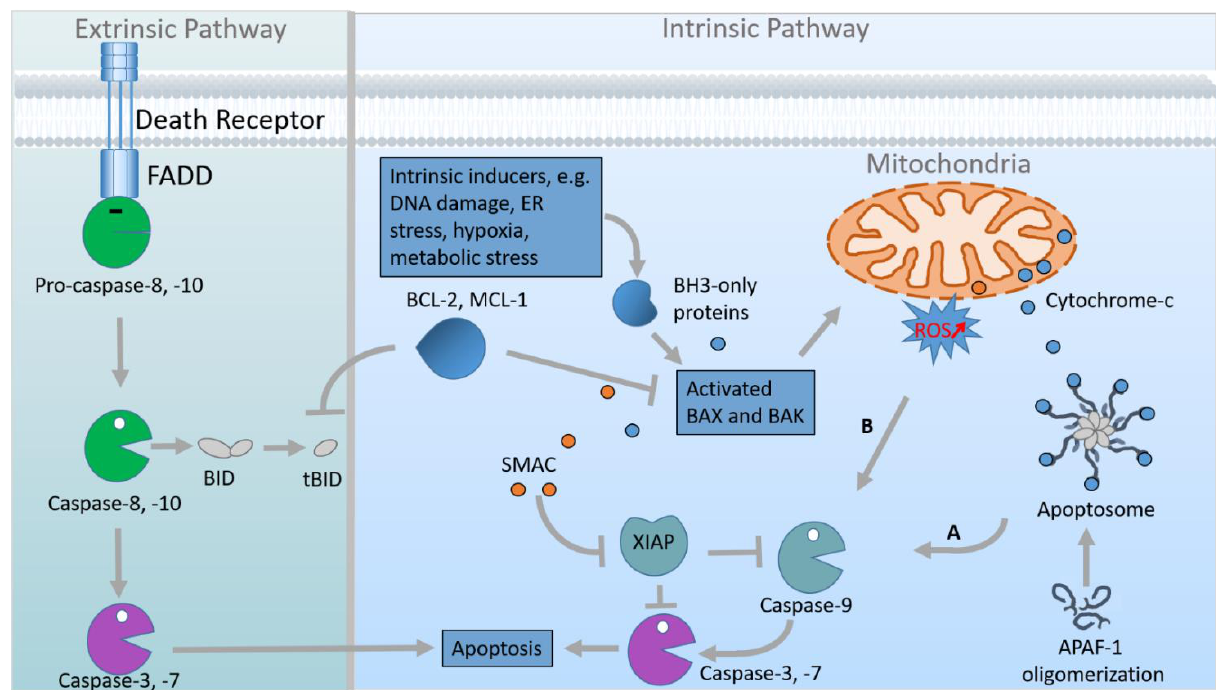
Figure 2. Extrinsic and intrinsic apoptosis-inducing signalling pathways. The extrinsic apoptotic pathway ( left panel ) is induced upon binding of a cognate ligand to the corresponding transmembrane death receptor such as the Tumour Necrosis Factor (TNF)-Related Apoptosis-Inducing Ligand (TRAIL) to its receptor (TRAILR). This results in activation of pro-caspases (Pro-Caspase-8 and Pro-Caspase-10, green pacman) through dimerisation mediated by adaptor proteins such as the FAS-Associated Death Domain Protein (FADD). Active Caspase-8 and Caspase-10 subsequently process and activate Caspase-3 and Caspase-7 (purple pacman) to induce apoptosis. The intrinsic pathway of apoptosis (right panel) is subdivided into apoptosome-dependent apoptosis (A) and apoptosome-independent apoptosis (B). Apoptosome-dependent apoptosis requires different intrinsic inducers (blue box upper left) that engage BCL-2 Homology Domain 3 (BH3)-only protein activation to activate BAX and BAK. Activated BAX and BAK induce permeabilisation of the mitochondrial outer membrane. Anti-apoptotic BCL-2 family proteins (e.g., BCL-2 and MCL-1) counteract this process. Subsequently, mitochondrial intermembrane proteins (Second Mitochondria-Derived Activator of Caspases (SMAC) and Cytochrome-c) are released into the cytosol, and then Cytochrome-c binds to Apoptotic Protease Activating Factor 1 (APAF-1) which assembles to the apoptosome and activates Caspase-9. Apoptosome-independent apoptosis is triggered by increasing ROS levels, which results in APAF-1-independent Caspase-9 activation. Active Caspase-9 activates Caspase-3 and Caspase-7 to induce apoptosis. Mitochondrial release of SMAC facilitates apoptosis by blocking the caspase inhibitor X-linked Inhibitor of Apoptosis Protein (XIAP). Caspase-8 cleavage of the BH3-only protein BH3-interacting domain death agonist (BID) enables crosstalk between the extrinsic and intrinsic apoptotic pathways. tBID, truncated BID; ER, endoplasmic reticulum; MCL1, myeloid cell leukaemia 1; tBID, truncated BID; ROS, reactive oxygen species.